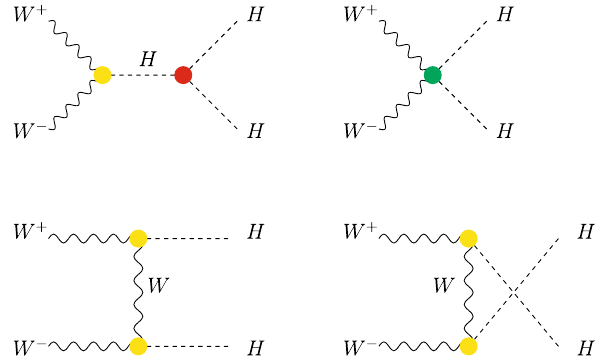
Fig. 38 Diagrams contributing to the W − W + → H H subprocess in the unitary gauge